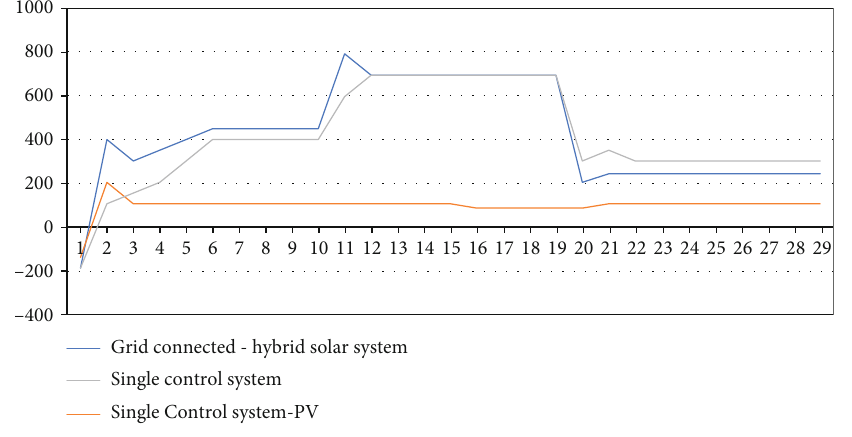
Figure 8: The output power of single-generator systems versus grid-connected solar power systems is compared. Table 3: Initial